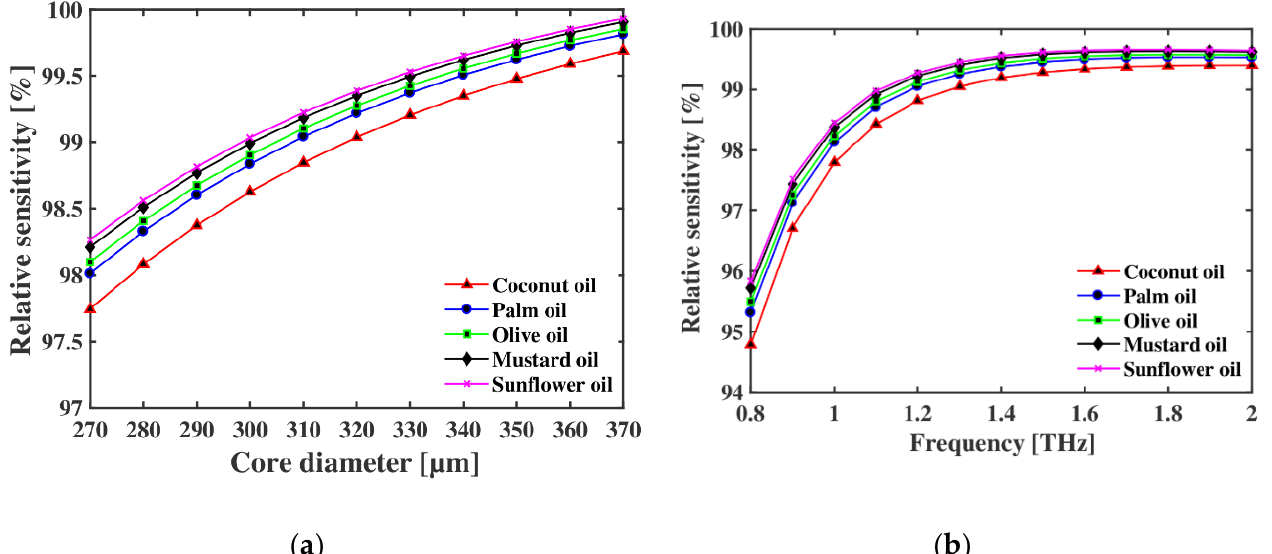
Figure 3. Relative sensitivity variations of the proposed sensor for ( a ) different core diameters at 1.6 THz and ( b ) different operating frequencies at 340 µm core diameter for sunflower, mustard, olive, palm, and coconut oil.